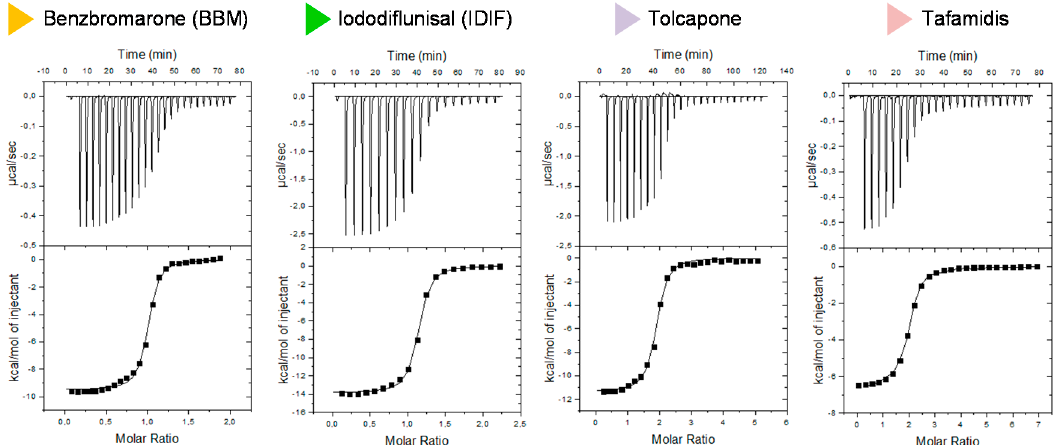
Figure 5. Thermograms of different complexes between TTR and small-molecule compounds: TTR + BBM, TTR + IDIF, TTR + tolcapone and TTR + tafamidis. Table 1. Thermodynamic parameters for interaction of TTR with small-molecule compounds including some TTR stabilizer drugs analyzed by ITC.